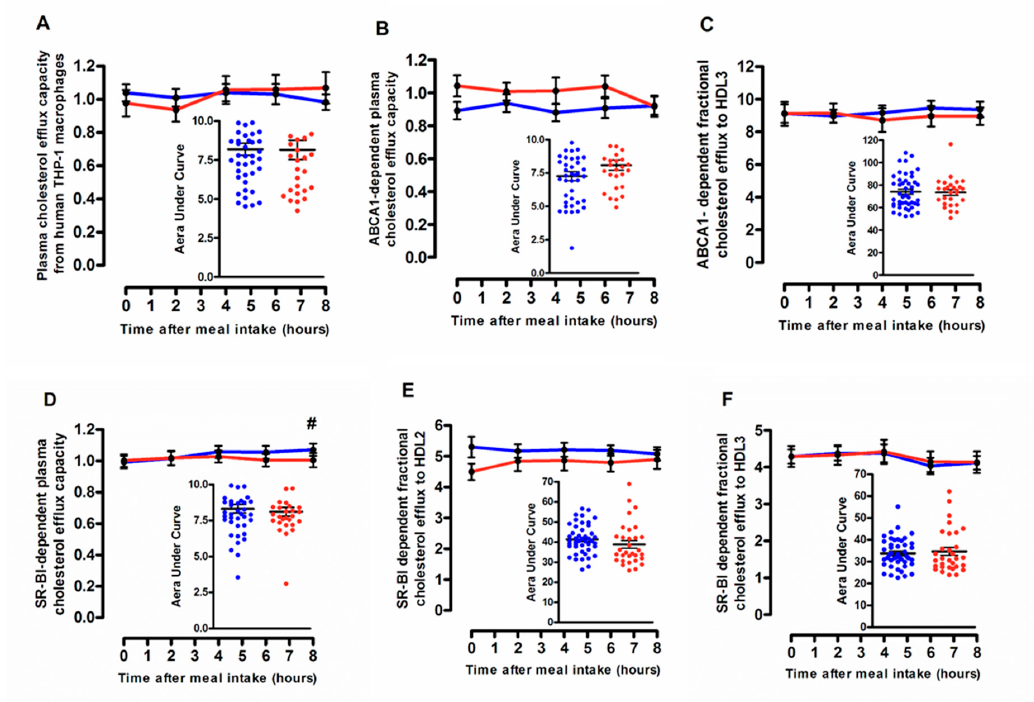
Figure 4. Cholesterol efflux capacity of plasma or isolated high-density lipoprotein (HDL) particles in subjects from G Low (blue curve) and G High (red curve). Line plots showing the capacity of 40-fold diluted plasma to mediate cellular free cholesterol efflux from human cholesterol-loaded THP-1 macrophages (A), via ABCA1 (B) and via Scavenger Receptor-BI (SR-BI) (D). ABCA1-dependent efflux capacity of isolated postprandial HDL3 (C); SR-BI dependent efflux capacity of isolated postprandial HDL2 (E) and HDL3 (F). Inserts represent area under the curve (AUC) in subjects from G Low (blue dots) and G High (red dots). Values are mean ± SEM. # p < 0.05 versus before meal intake.